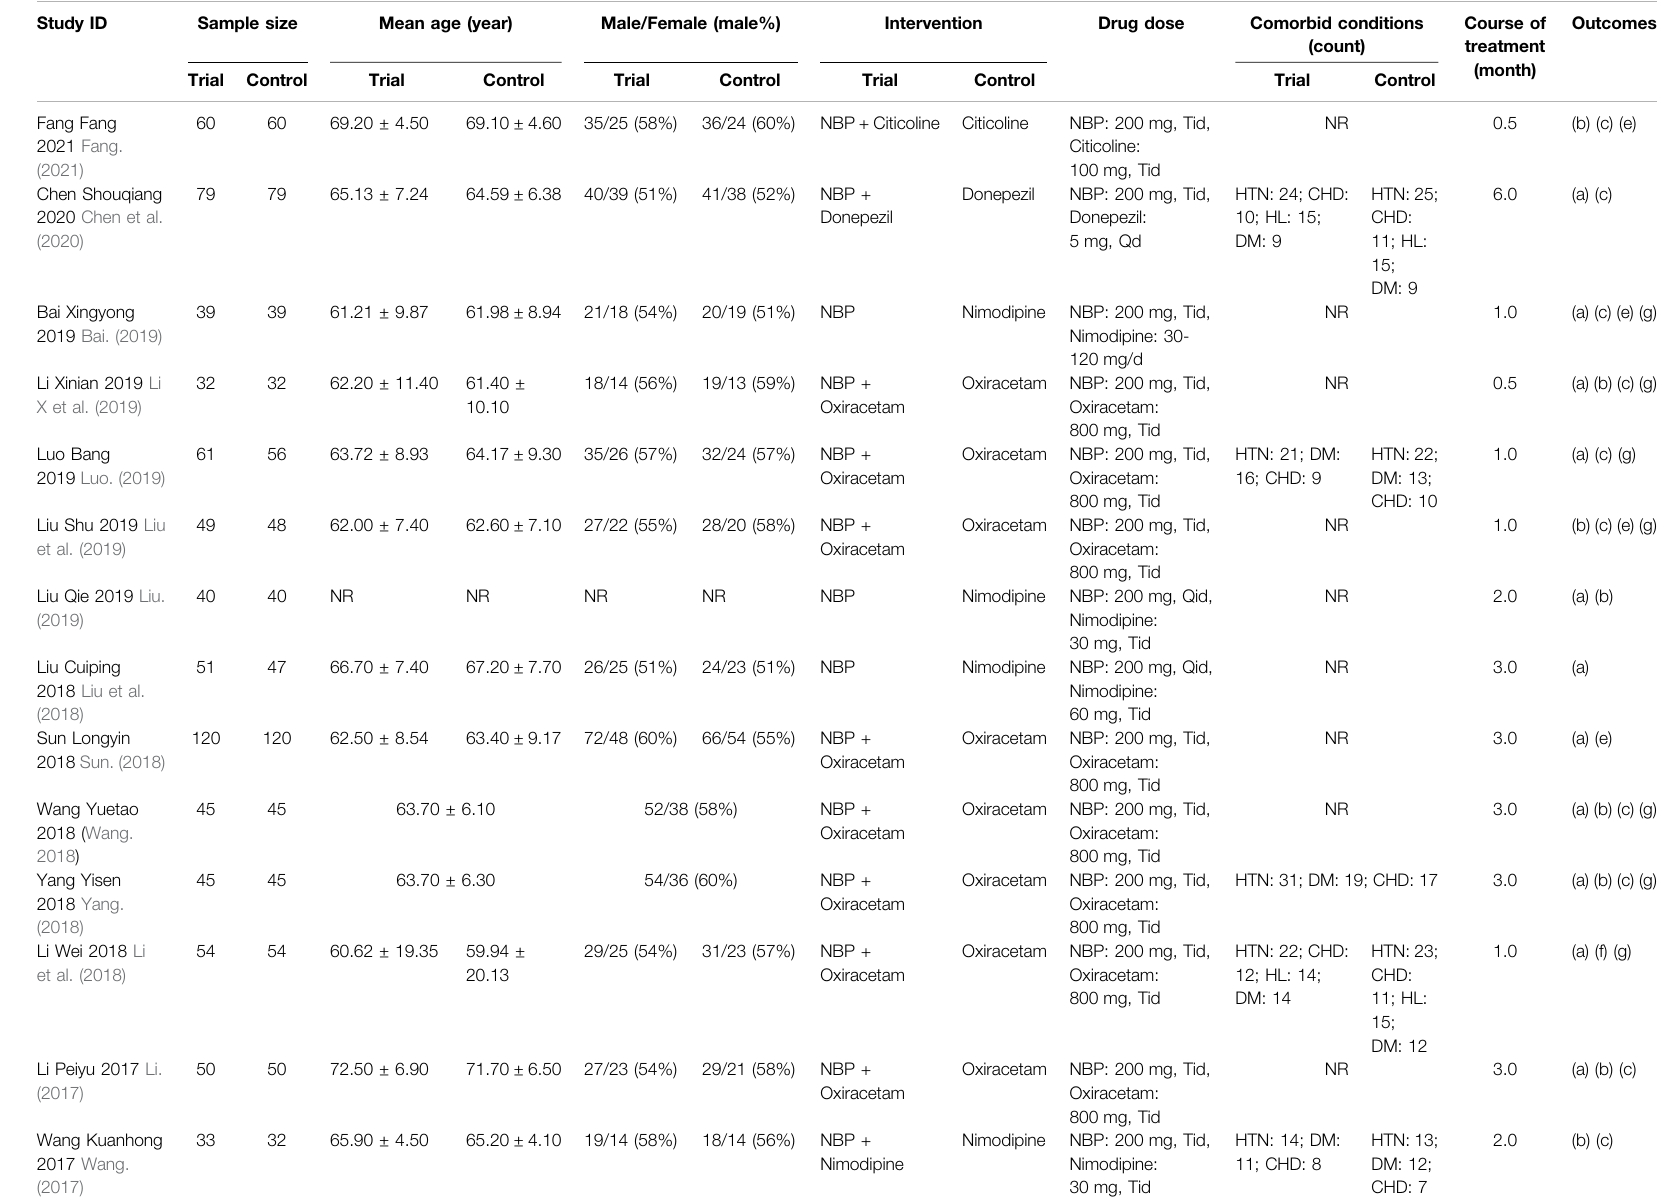
TABLE 1 | Characteristics of included